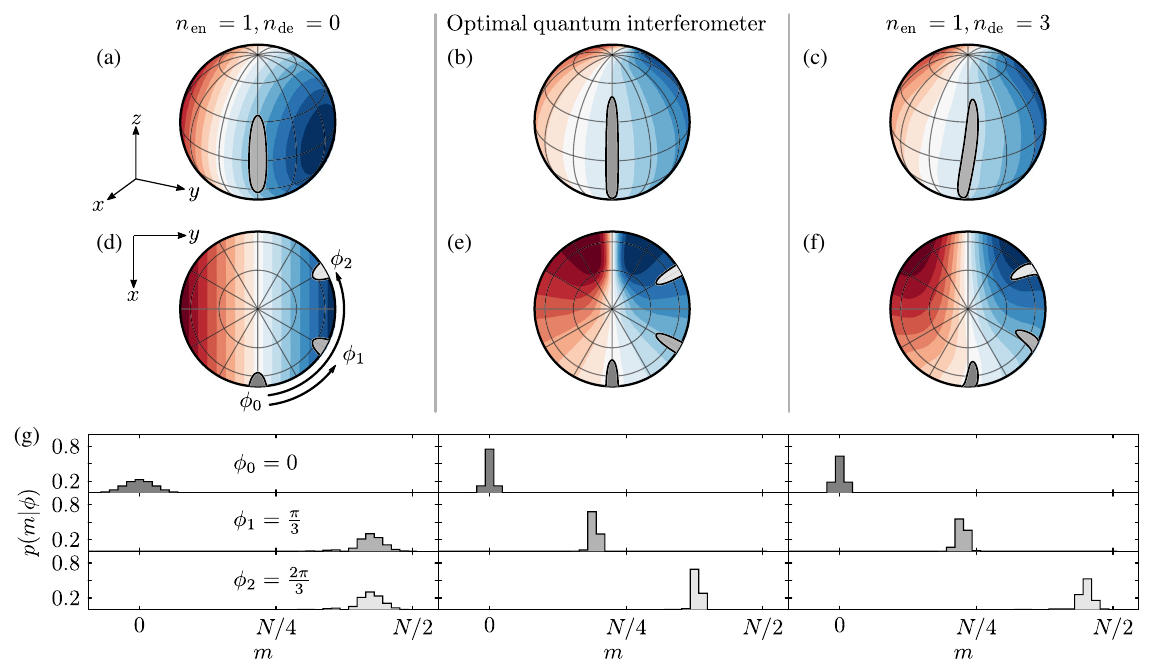
ψ FIG. 3. Visualization of quantum states j ψ ϕ i ¼ exp ð − i ϕ J , and quantum measurement operators as Wigner distributions on the z Þj in i generalized Bloch sphere for N ¼ 64 and δϕ ≈ 0 . 7 . The first [(a),(d)], second [(b),(e)], and third [(c),(f)] column correspond to ð n en ; n de Þ ¼ ð 1 ; 0 Þ (squeezed input state, and J y measurement operator), the optimal quantum interferometer, and to a (1,3) quantum circuit, respectively. Measurement operators are visualized as colored contours on the Bloch sphere corresponding to different measurement outcomes. The corresponding optimized (optimal) states j ψ ϕ i are shown at various angles ϕ as gray shaded areas. (a) – (c) Three-dimensional view of the generalized Bloch sphere with a state rotated to ϕ ¼ π = 3 . (d) – (f) Top view of the Bloch sphere with the state rotated to angles ϕ ¼ 0 ; π = 3 ; 2 π = 3 . (g) Measurement probability p ð m j ϕ Þ [see Eq. (9)] corresponding to the overlap between the contours of the measurement distribution and the respective state distribution, displayed in the same column. The three rows correspond to the above three angles ϕ . Note that for the J measurement the distributions at angles π = 3 and 2 π = 3 are indistinguishable in y measurement statistics. In contrast, for the OQI and the (1,3) quantum circuit these angles are well